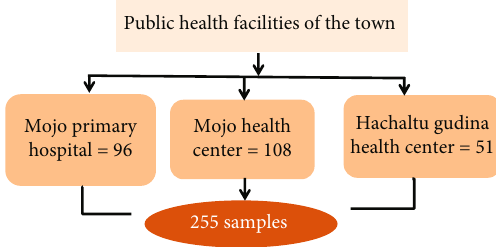
Figure 1: Schematic presentation of sampling procedures for women ’ s satisfaction on abortion care and associated factors in public health facilities of Mojo